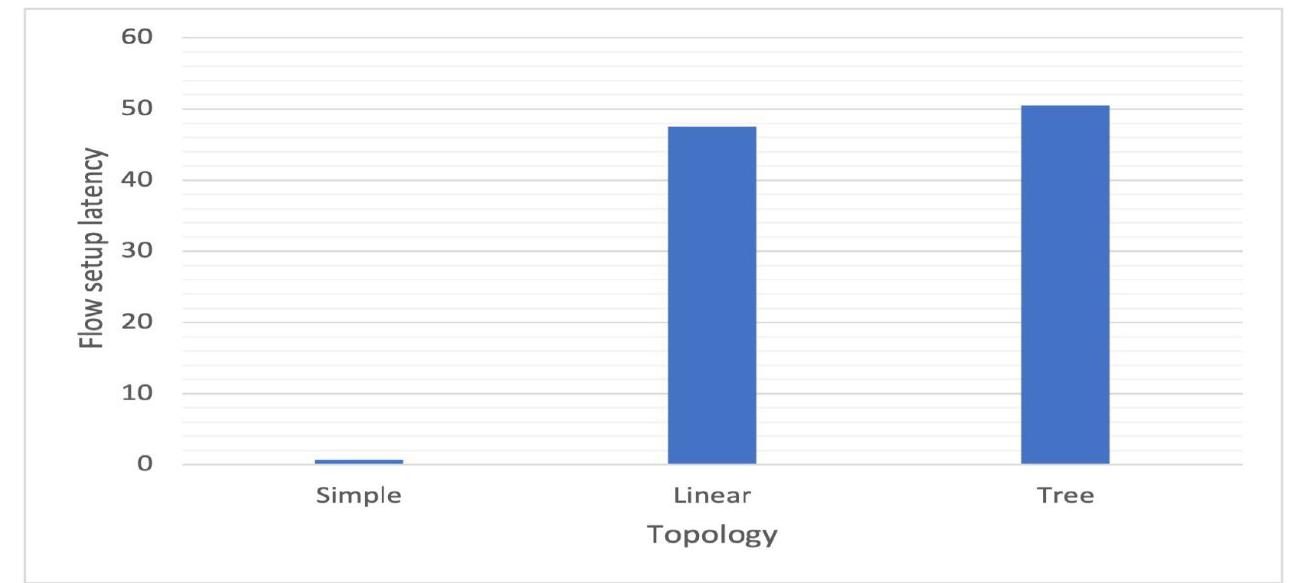
Figure 18. Graph showing flow setup latency with three topologies.